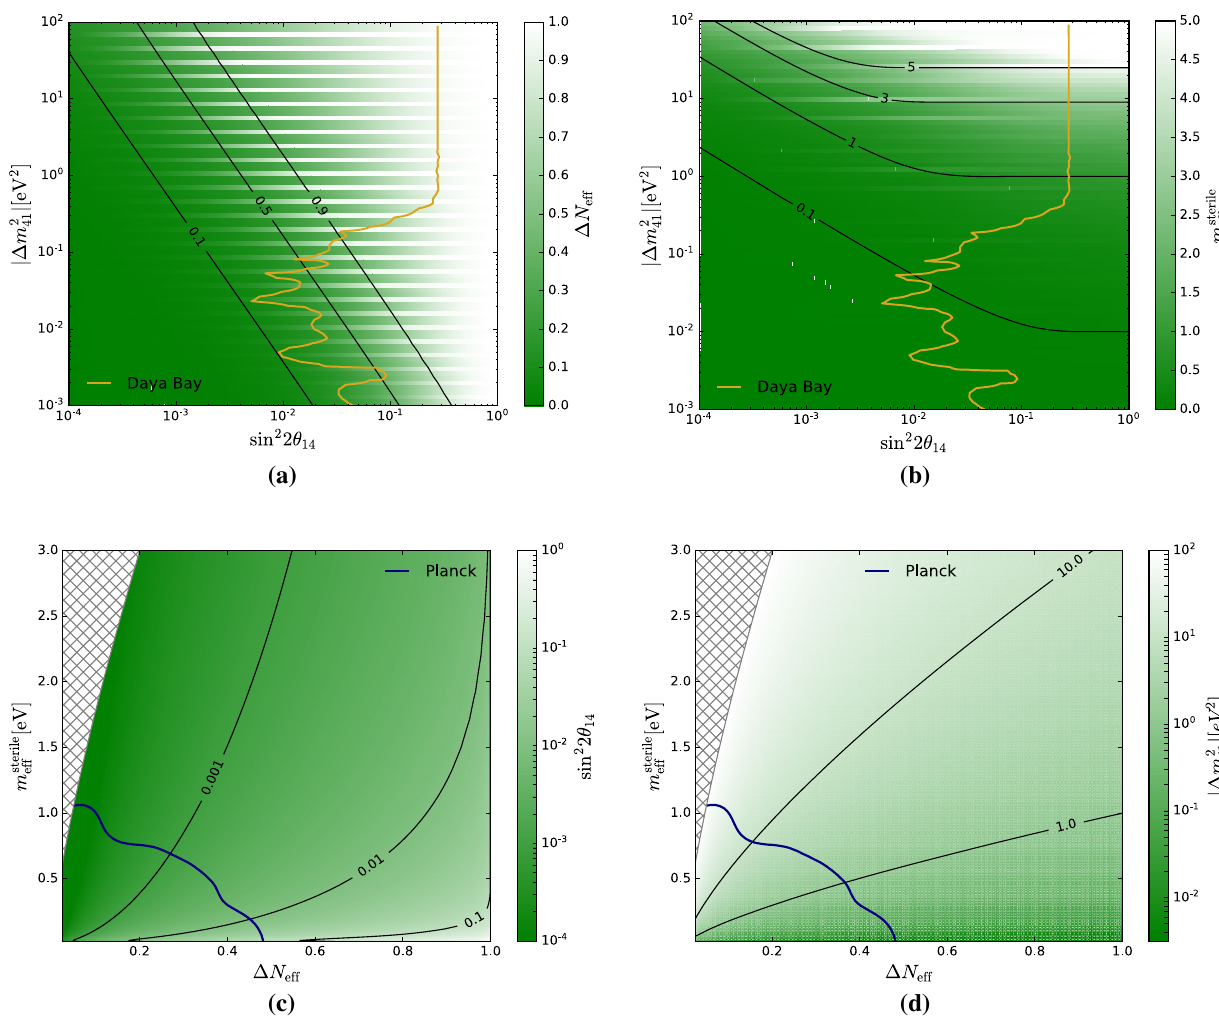
Fig. 1 a , b Cosmological parameters (cid:3) N sterile using LASAGNA, in the oscillation space of the 1 + 1 model that is relevant for ν e and ν e disappearance measurements. We use the thermal sterile neutrino mass (Eq. 8) and assume vanishing lepton asymmetry ( L = 0). We also show the Daya Bay exclusion contour; the region to the right of the contour is ruled out at the 95% Cl. c , d The oscil-